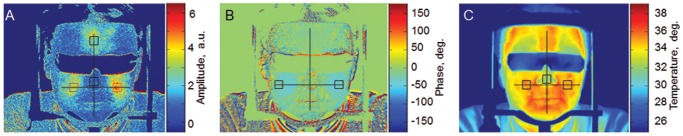
Examples of the images obtained with the BPI system and with the thermographic camera: (A) 2D distribution of the blood pulsation amplitude; (B) 2D map of the blood pulsation phase; (C) 2D distribution of the skin temperature.